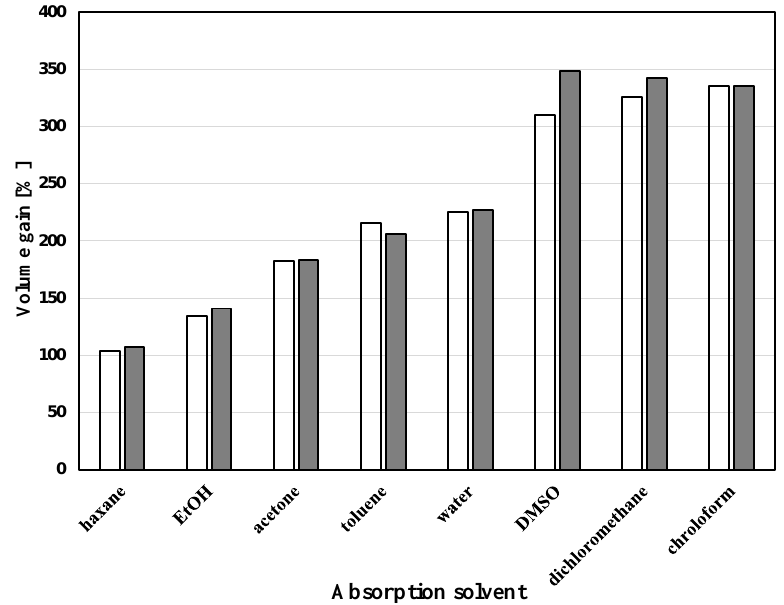
Figure 10. Absorption capacity of PEI-PEGDA200 (white) and DETA-PEGDA200 (gray) porous polymers, monomer concentration in reaction system: 20 wt %, feed molar ratio of PEI/PEGDA200: 2/7, DETA/PEGDA200: 2/5 (Case 2), preparation temperature: 20 °C.